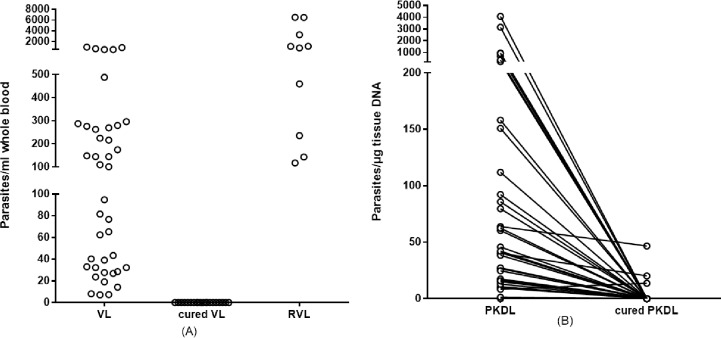
Parasite DNA can be detected in active, but not cured, disease states.In (A), parasite burden in blood samples from VL (n = 40), VL patients deemed to be cured by symptomatic response to treatment (n = 40) and RVL patients (n = 10) were measured. Each point indicates the data obtained from each individual sample. In (B), parasite burden in skin samples from PKDL patients before or after treatment (n = 40) were measured. Each point indicates the data obtained from each individual sample, and before and after data for each patient are linked by the connecting line.